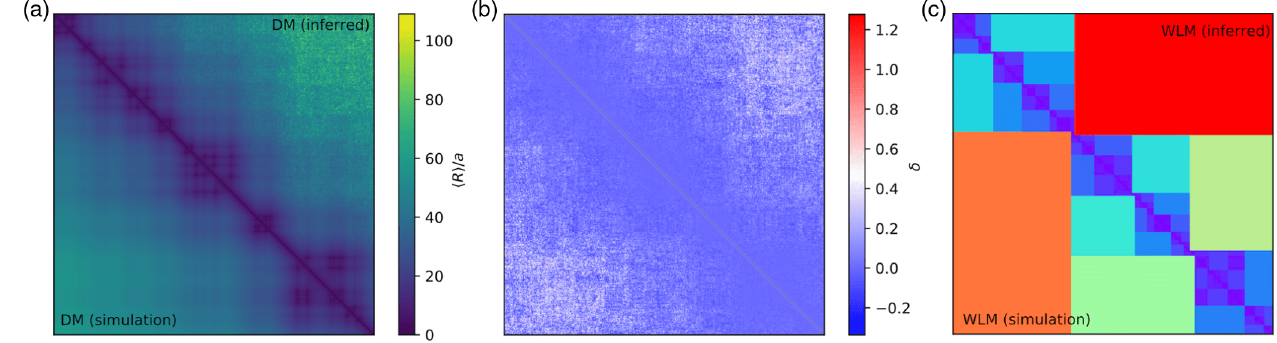
¯ R ¯ R ¯ R ) for the GRMC. (a) The simulated (lower triangle) and the constructed ¯ R . The constructed is mn i 2 . 0 a . The location of the loop anchors is c ¼ − d =d , where d and d are the inferred I S Þ S I S